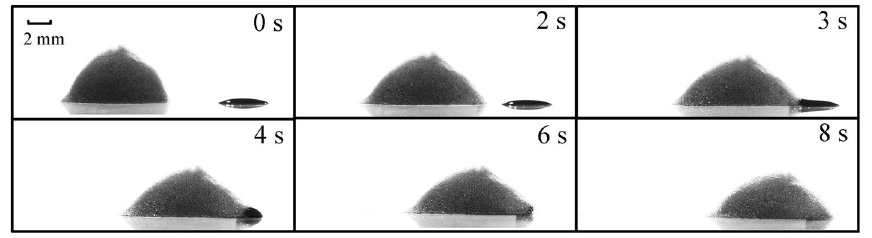
Figure 4. Snapshots of the magnetic foam option process. When t = 2 s, the foam starts to move; when t = 3 s, the foam comes into contact with oil droplet; and when t = 8 s, the foam starts to move with the oil